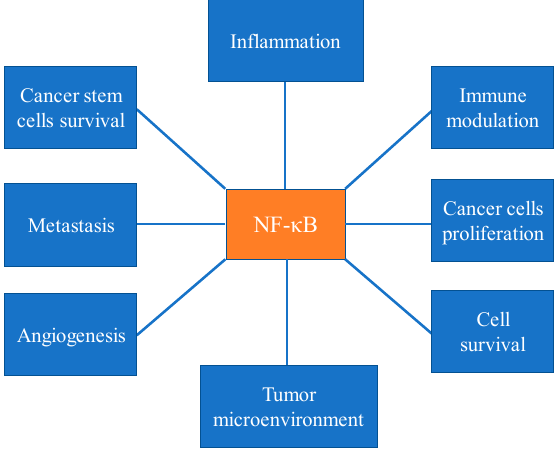
Figure 1. Different cellular events, including inflammatory response, immune cells modulation, cancer cell proliferation, cancer cell survival, tumor microenvironment, angiogenesis, metastasis, stem cell survival activates NF- κ B pathway.